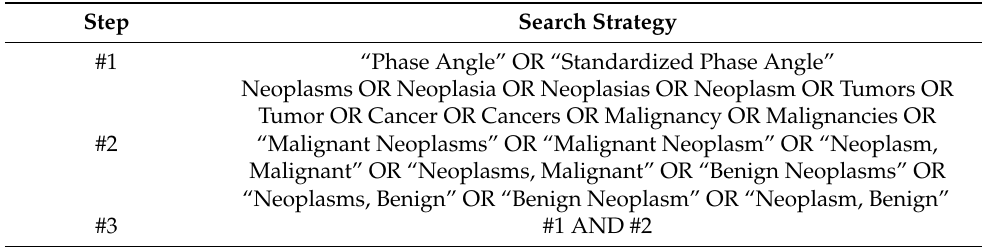
Table 1. Search strategy in electronic